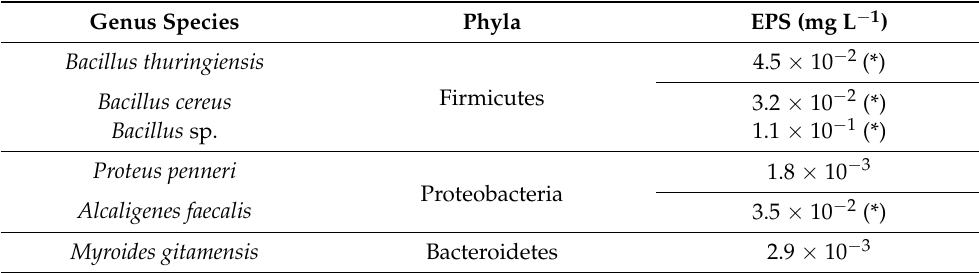
Table 2. Concentration of exopolysaccharides (EPSs, mg L − 1 ) produced by bacteria in in vitro assays (*, p < 0.05).